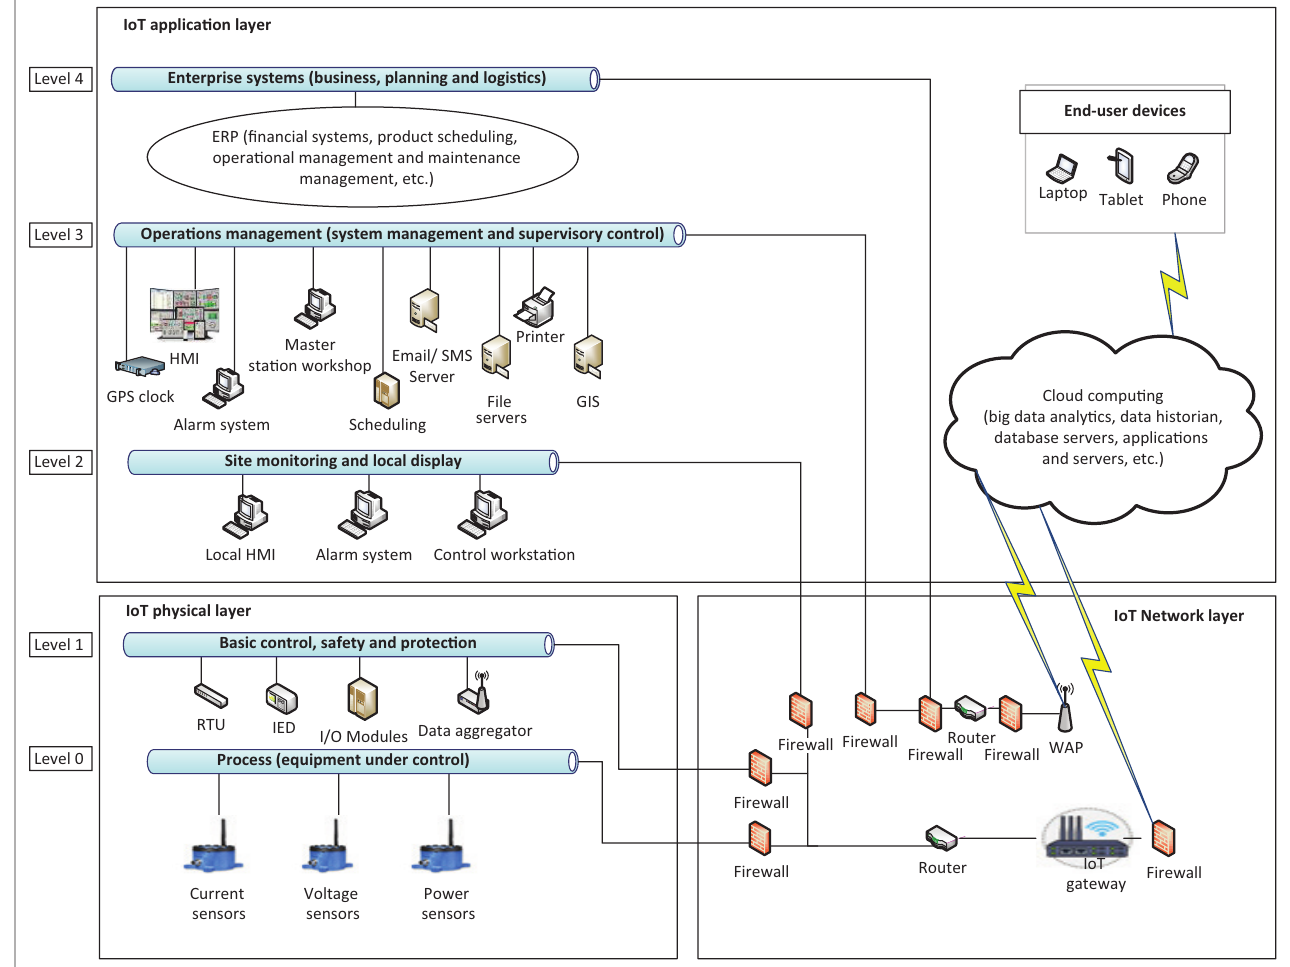
FIGURE 3: The proposed Internet-of-Things-Supervisory Control and Data Acquisition system architecture (author’s